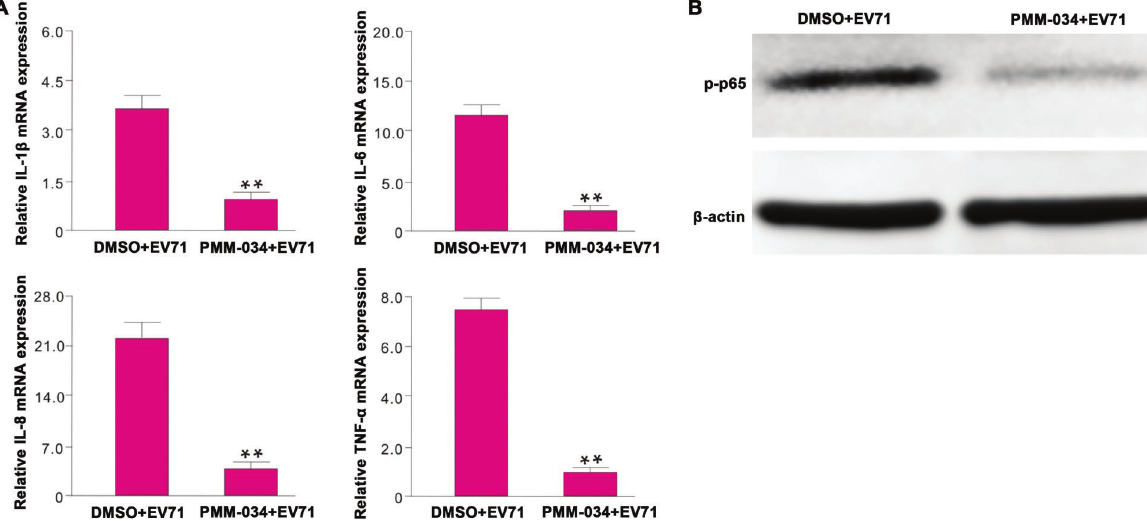
Figure 5. Effects of PMM-034 on the mRNA levels of pro-in fl ammatory cytokines and phospho-p65 protein expression in rhabdomyosarcoma (RD) cells. RD cells were infected with human enterovirus 71 (EV71) for 1 h, then treated with 10 m g/mL PMM-034 or DMSO for 23 h. A , mRNA levels of IL-1 b , IL-6, IL-8, and TNF- a were detected by real-time RT-PCR. GAPDH was used as the internal control. Data are reported as means ± SD of at least 3 independent experiments. **P o 0.01, Student ’ s t -test. B , Phospho-p65 protein expression was detected by western blotting. b -actin was used as the internal